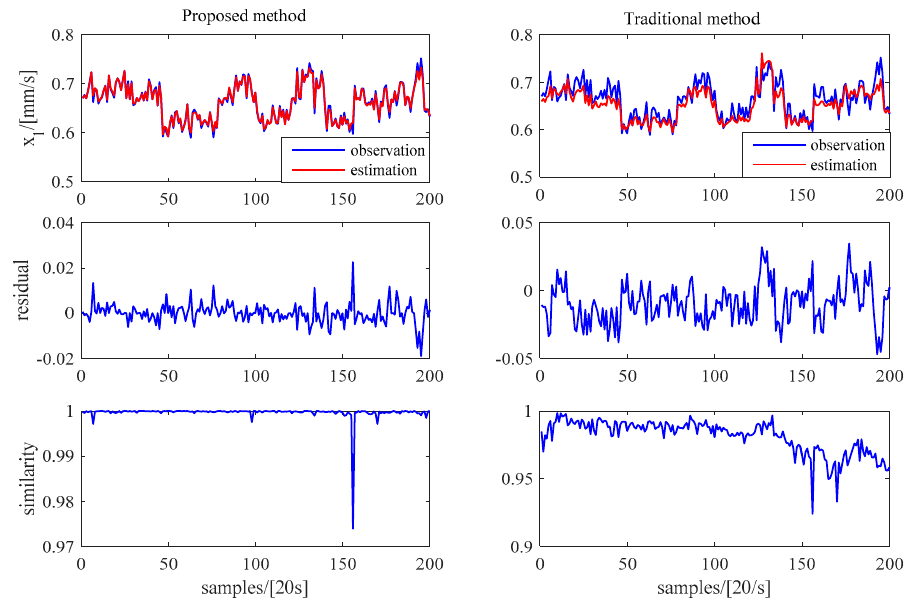
Figure 5. Comparison for proposed method and traditional method for horizontal vibration in condition I.